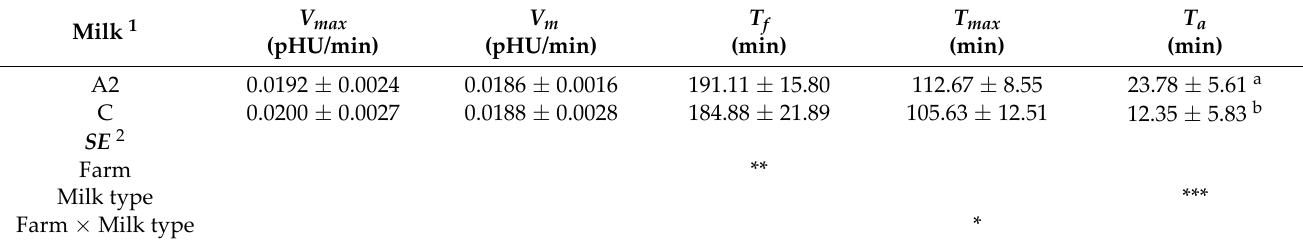
Table 5. Acidification properties of A2 and control milks.